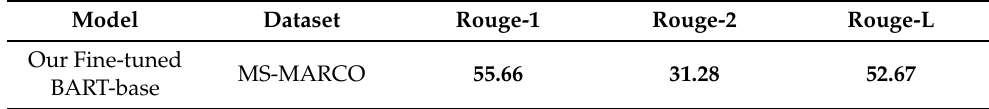
Table 4. The performance of the fine-tuned BART-base